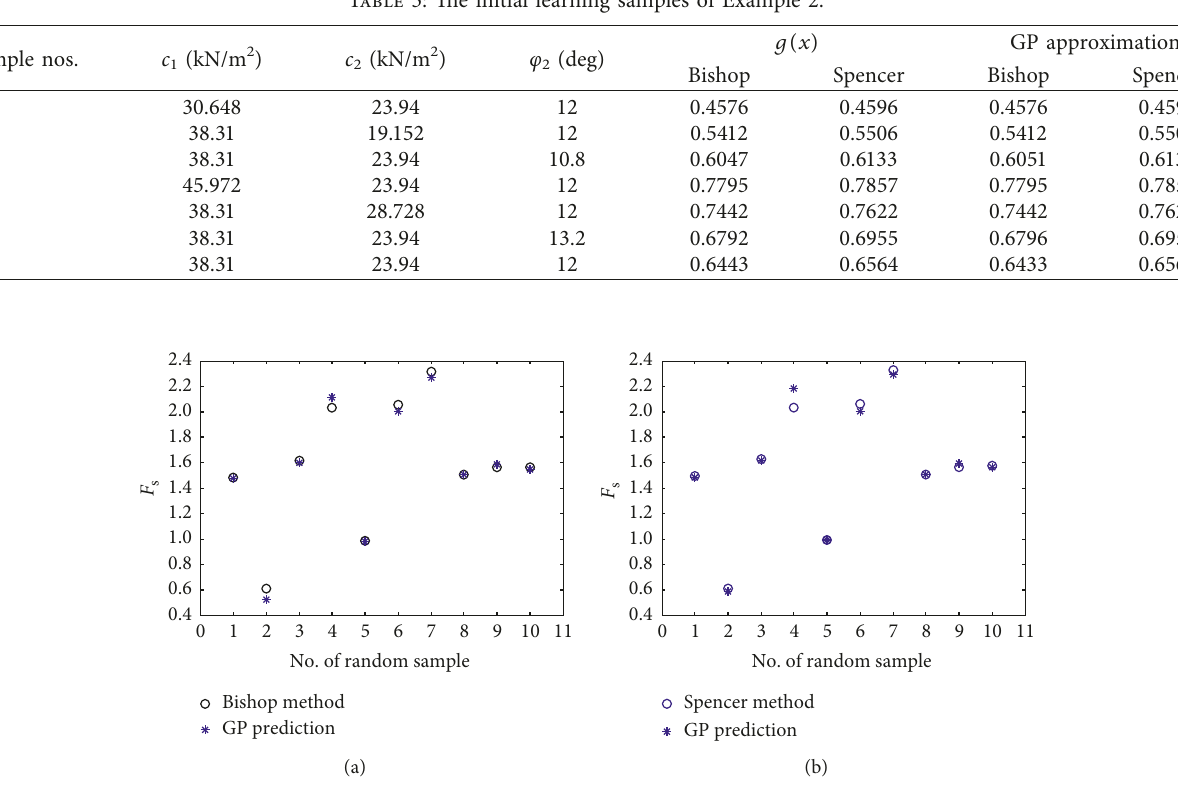
Figure 4: Comparison between safety factors calculated by (a) Bishop method and GP prediction and (b) Spencer method and GP prediction.